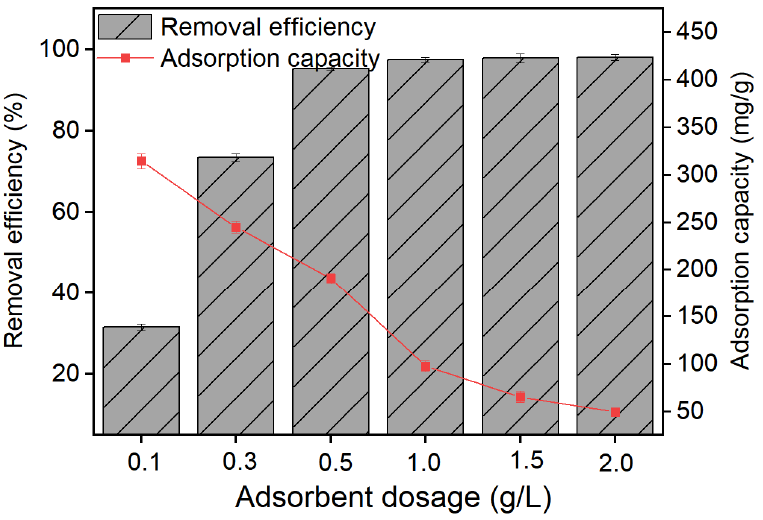
Figure 4. Effects of the dosage of CS 2 C@SBA − 3 on the removal of V(V). Conditions: V(V) initial concentration = 100 ppm, pH value = 3.0, experimental temperature = 298 K, contact time = 24 h.